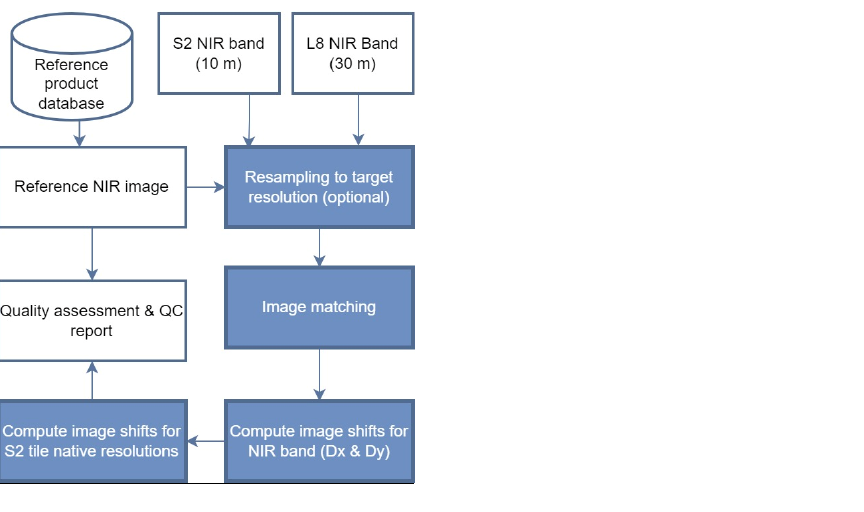
Figure 2. Geometric processing workflow including co-registration and geometric quality assess- ment.